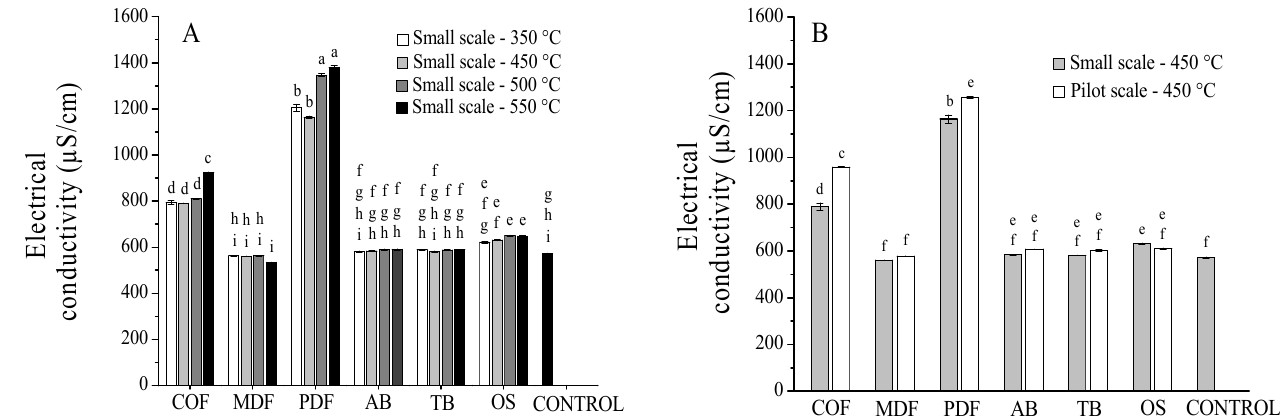
Figure 4. Influence of pyrolysis temperature ( A ) and upscaling ( B ) on the EC of biochar submerged in “Organization for Economic Cooperation and Development” (OECD) standard water. Means with different letters indicate statistically significant difference (Tukey’s HSD, p < 0.05). COF = coffee husks, MDF = medium‑density fiberboard, PDF = palm date fronds, AB = AB wood waste, TB = tree bark, OS = olive stones, and control = OECD standard water. The lowercase letters above the columns are presented to compare different columns to each other. Columns with the same letter are not statistically different from each other, while columns with differing letters are statistically different from each other.